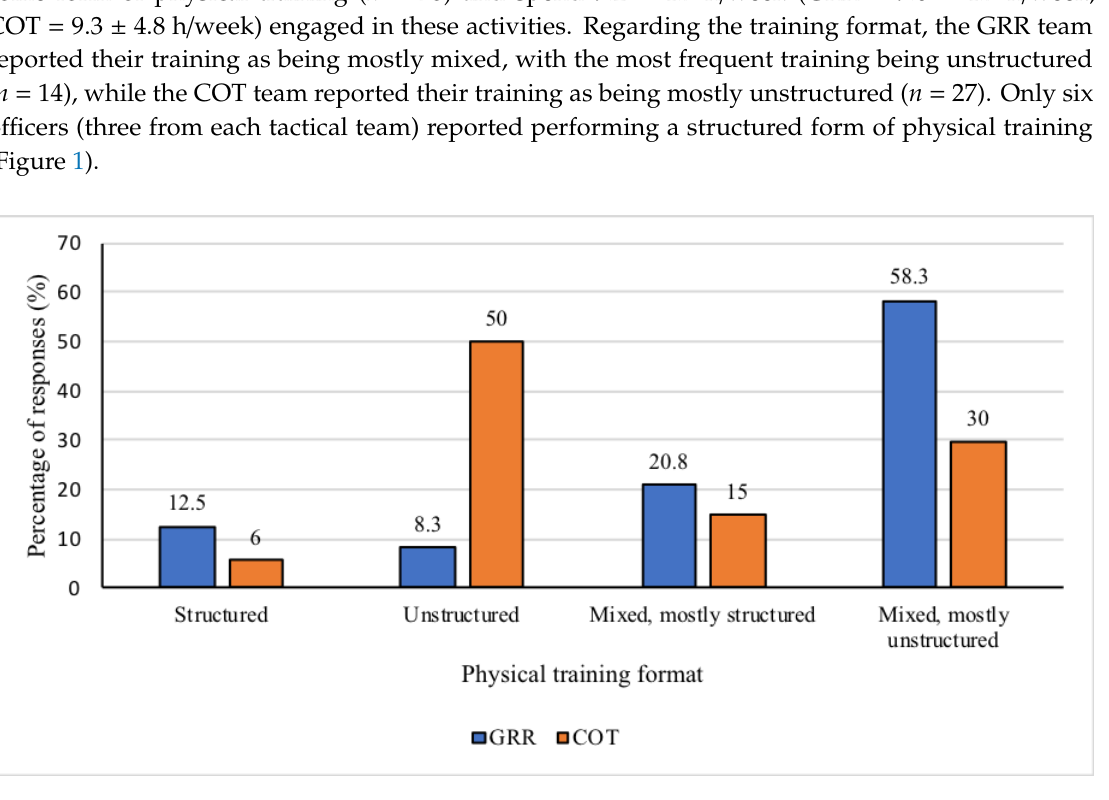
Figure 2. Percentage of responses to training supervision for both special operations units, chosen from supervised, unsupervised, mixed (but mostly supervised), or mixed (but mostly unsupervised). COT = Tactical Operations Command; GRR = Rapid Response Group.